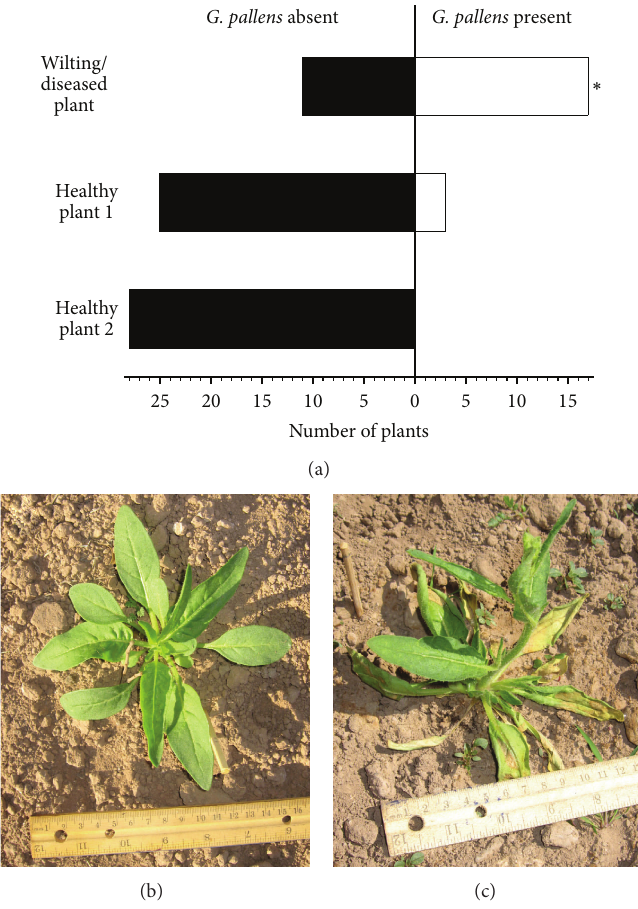
Figure 7: G. pallens is more likely to be found on wilting plants. The graph shows the number of wilting, diseased, and neighboring healthy plants found to harbor G. pallens individuals (a). Healthy plant 1 (b) was on average ca. 1.5 m, and healthy plant 2 was ca. 2-3m away from the wilting plant (c). The asterisk indicates significant differences between the presence of G. pallens in both sets of healthy plants and wilting plants in a Fisher’s exact test, 𝑃 < 0.0001